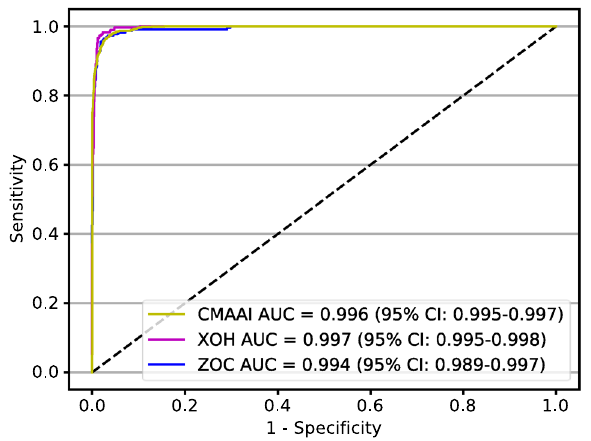
Fig. 2 Receiver operating characteristic curves showing the ability of the DLIFS in detecting and fi ltering out poor-quality ultra-wide fi eld fundus images. AUC area under the receiver operating characteristic curve, CMAAI Chinese Medical Alliance for Arti fi cial Intelligence, DLIFS deep learning-based image fi ltering system, XOH Xudong Ophthalmic Centre, ZOC Zhongshan Ophthal- mic